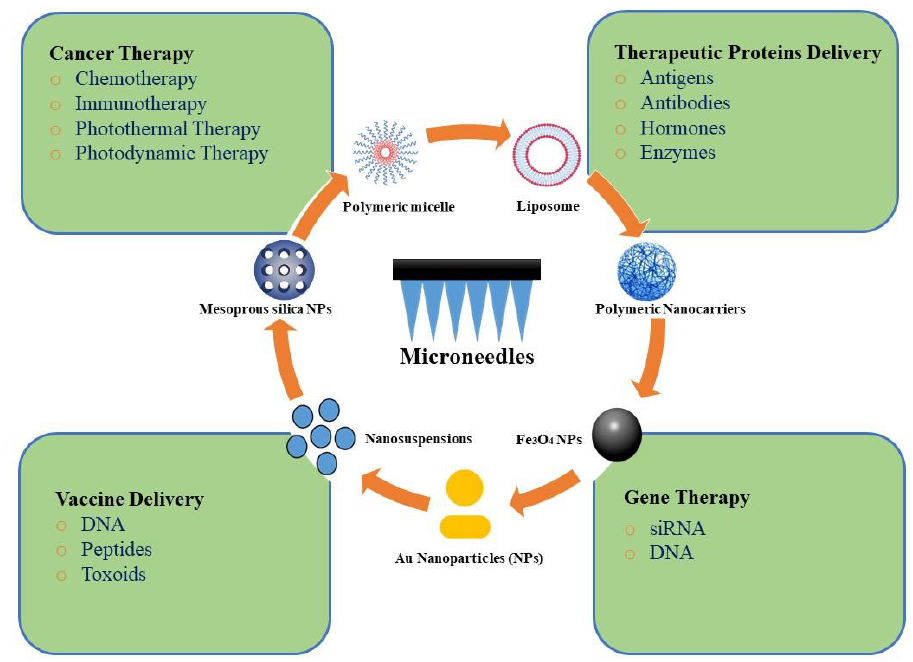
Figure 3. Combinatorial applications of microneedles (MNs) with nanoparticles (NPs). Table 2. Microneedle-assisted transdermal delivery of nanoparticles (NPs). Type of MNs Ref.